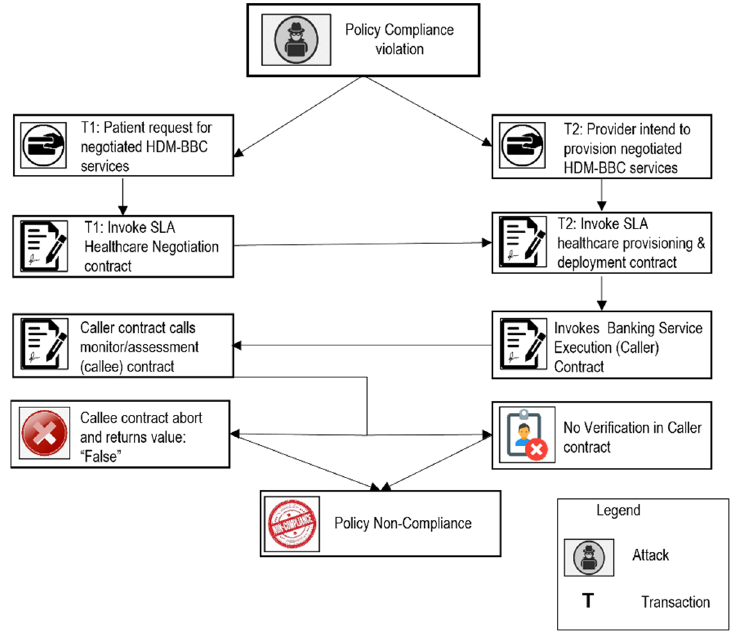
Figure 9. Threat model for mishandled exceptions scenario 3: Policy non-compliance.